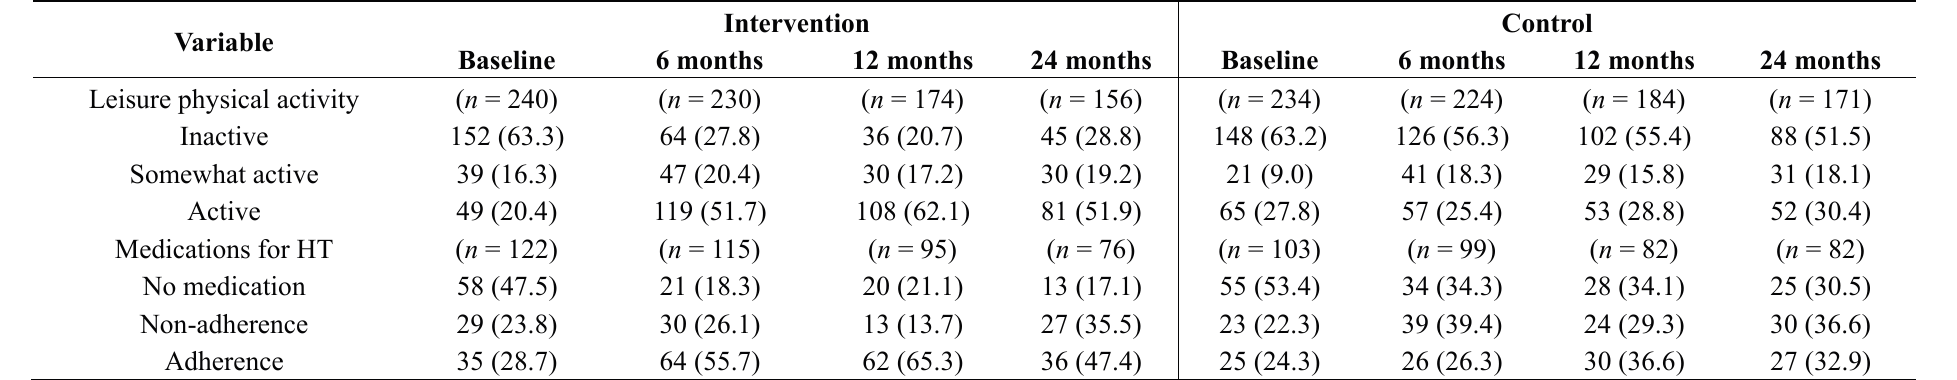
Table 3. Number (%) of participants in the two assigned groups by activity and use of HT medication category at baseline and follow-up. Variable